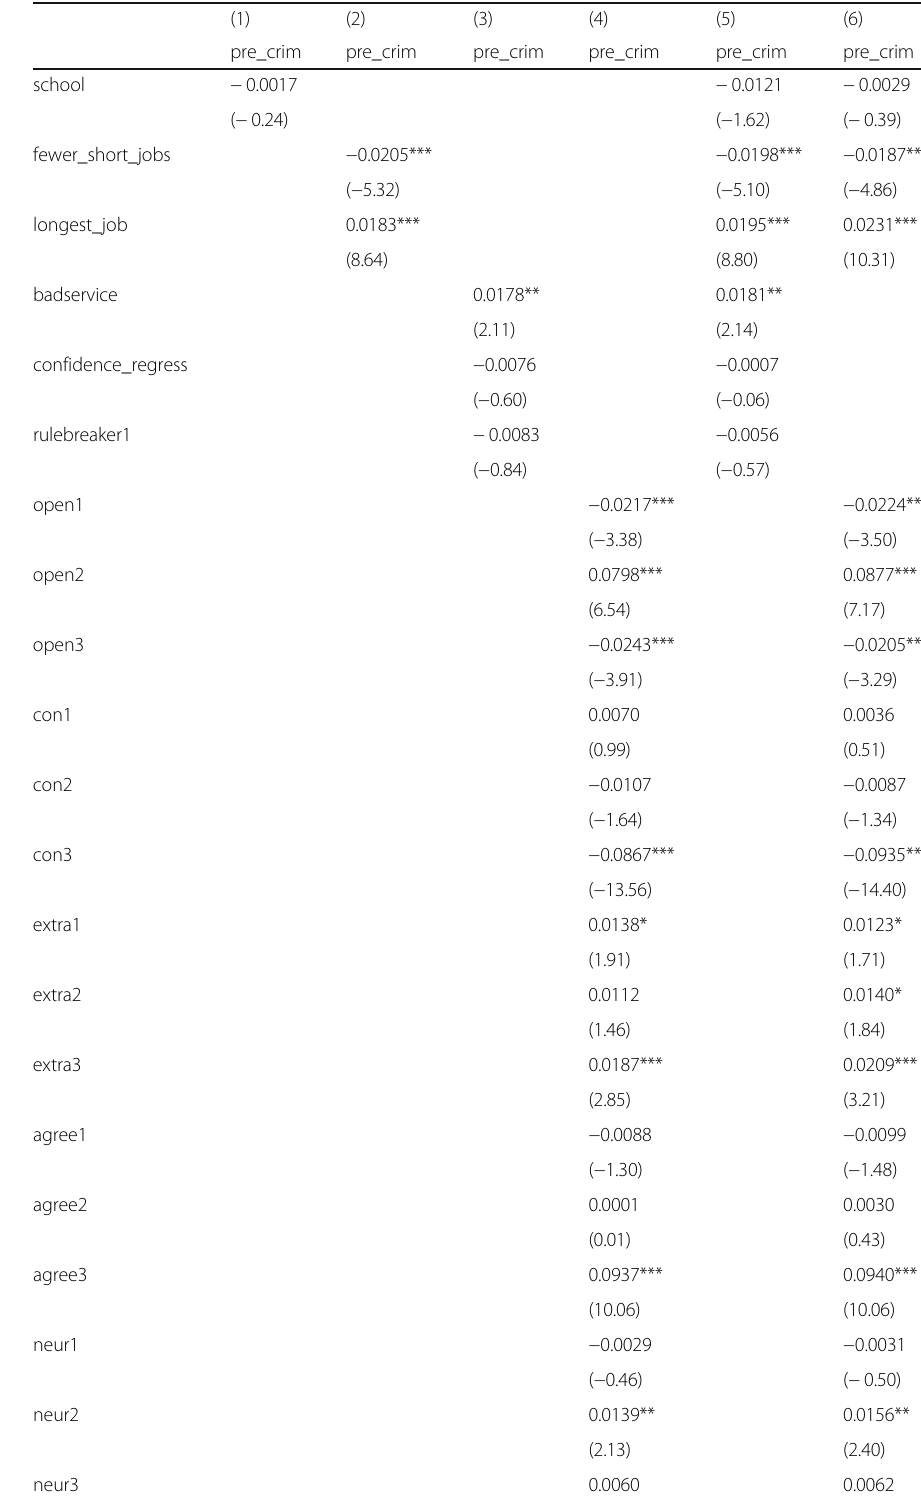
Table 19 Question-level correlates of criminal background in hired population (customer